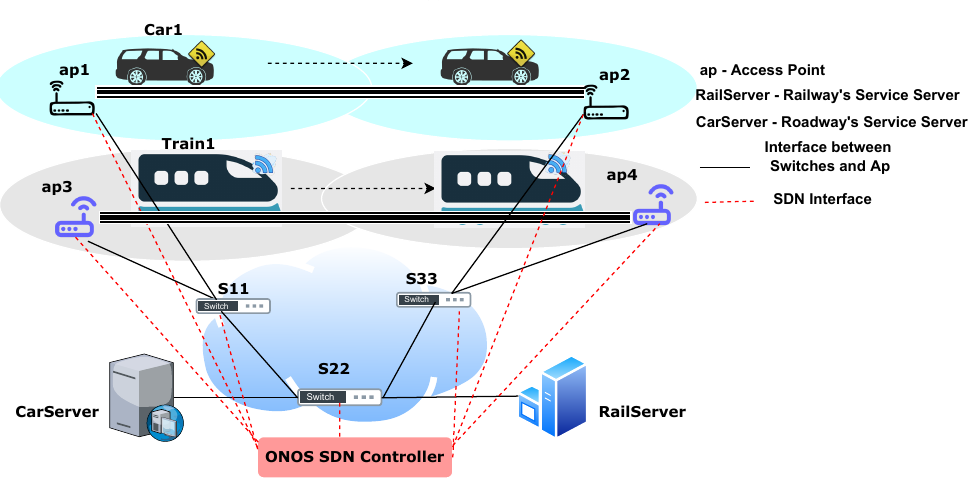
Figure 3. S2(5/6)1: Different Access Network and Shared Core, Track Parallel to